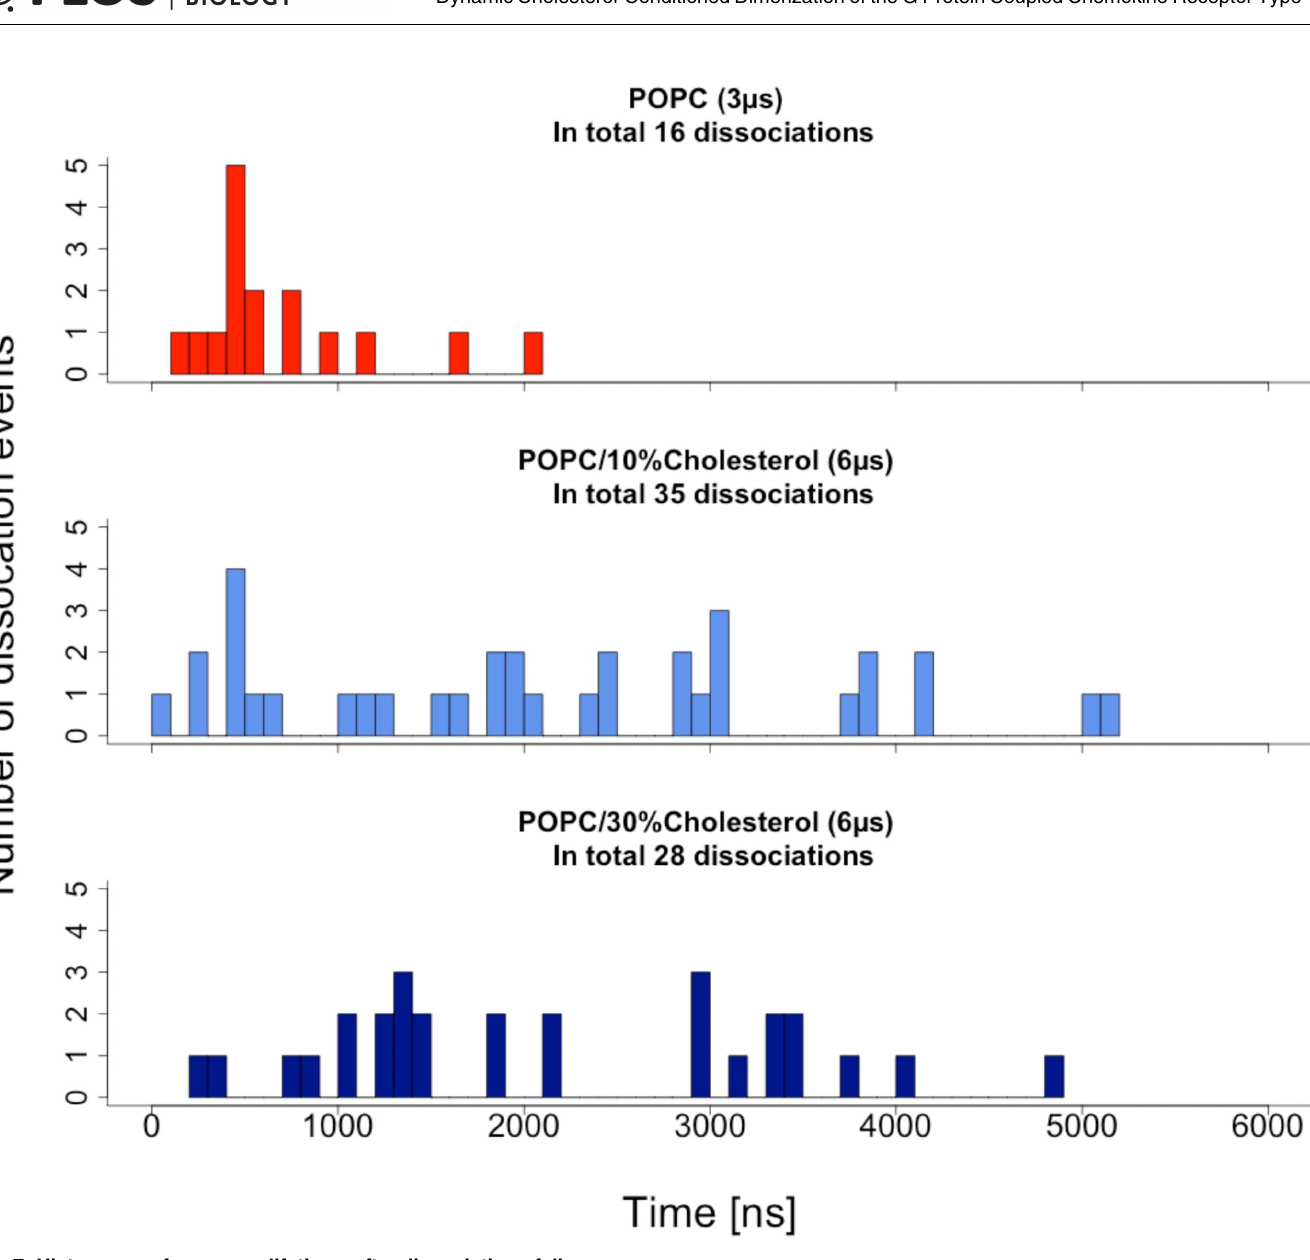
Fig 7. Histograms of monomer lifetimes after dissociation of